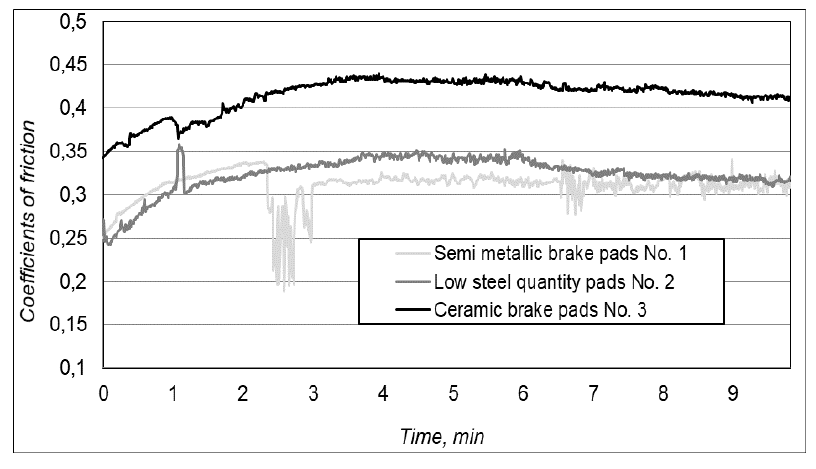
Fig. 5 Variation of the coefficient of friction during testing (1.75